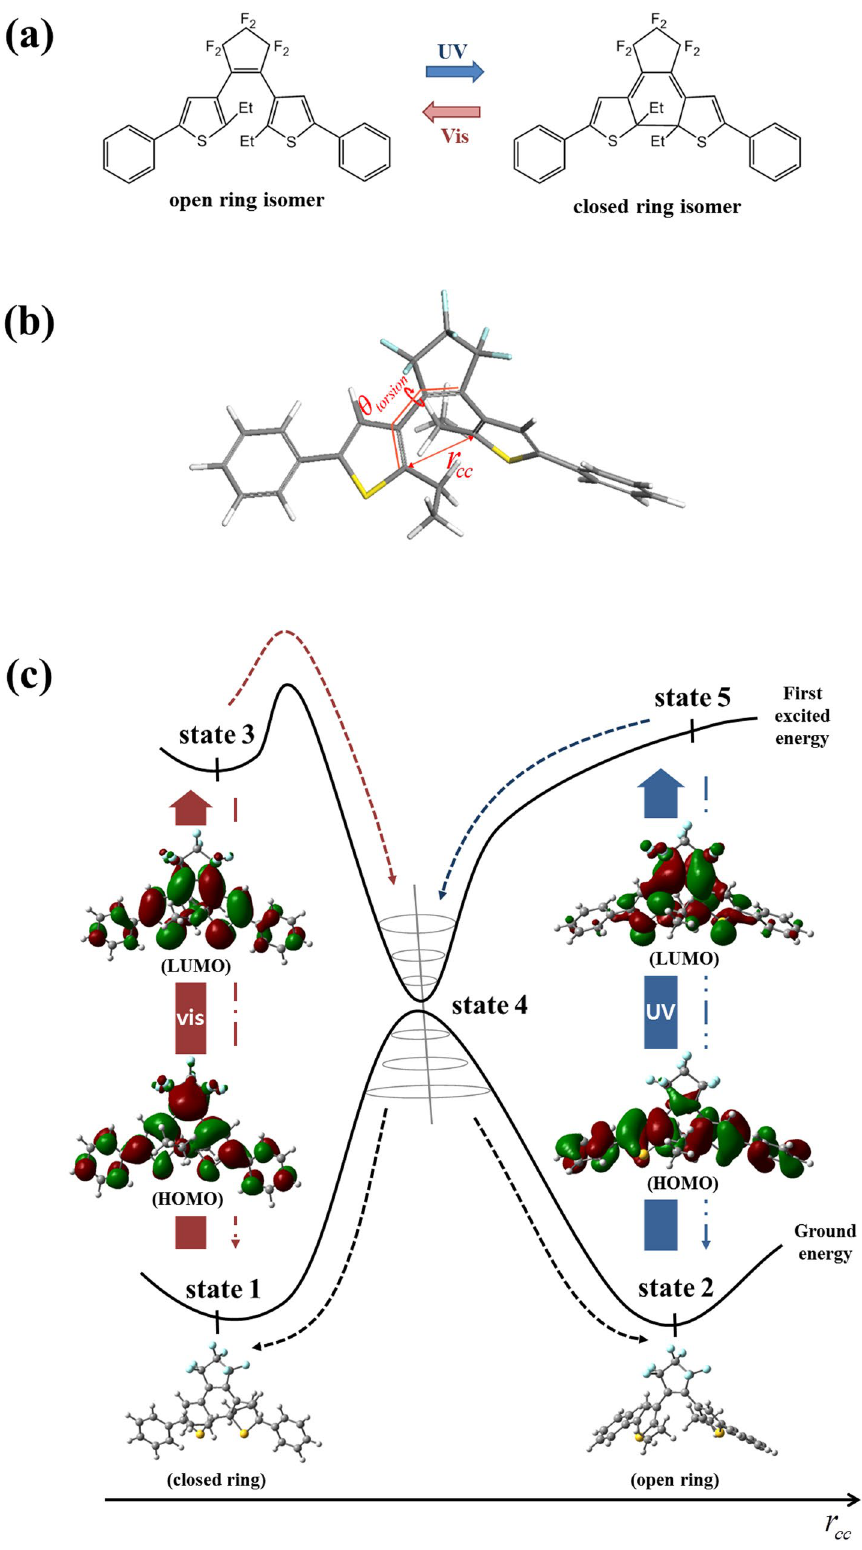
Figure 1. ( a ) Photoisomerization of diarylethene. ( b ) Reaction coordinate of ring opening/closing reaction. ( c ) The population transition path consists of radiative and non-radiative processes. Excitation (&#x2796;) and spontaneous decay ( ─ · ─ ) indicate radiative transition. Vibrational relaxation ( ─ ─ ─ ─ ) corresponds to non-radiative process. Each molecular orbital transition (HOMO → LUMO, isovalue: 0.02) corresponds to the most significant contribution for the excitation (ground- to first excited state) which is obtained from TDDFT